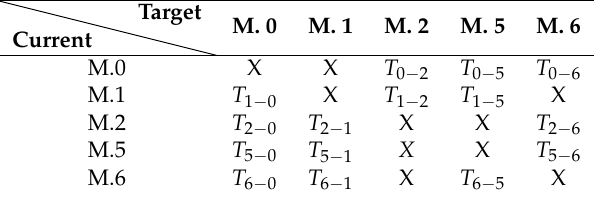
Table 2. Allowed transitions between operation